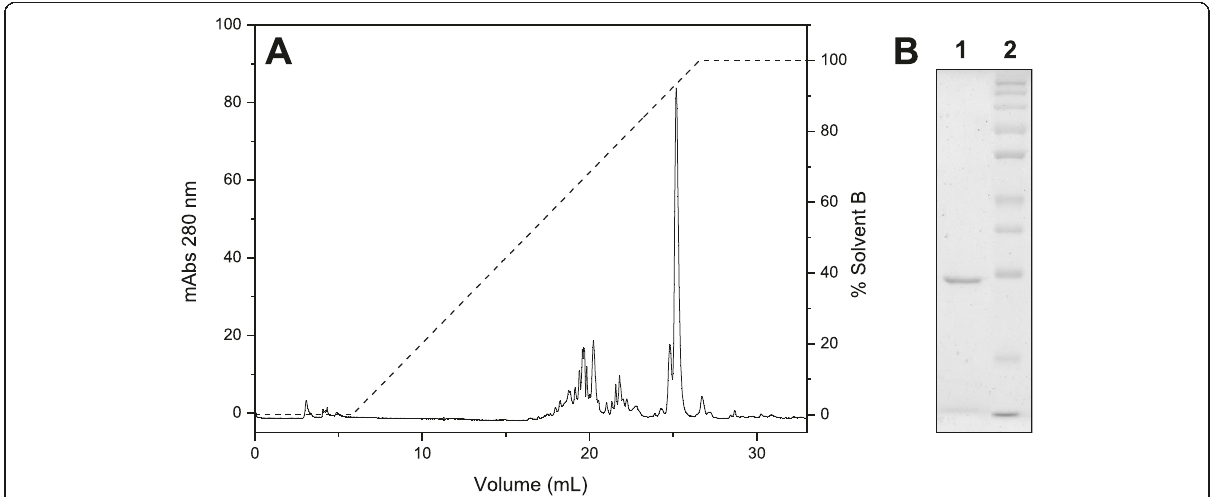
Fig. 5 a Evaluation of the purity level of fraction D4 after Vivaspin® 20 on a C18 reverse phase column. After having been subjected to ultrafiltration on a Vivaspin® 20 system, fraction D4 was evaluated by RP-HPLC using a C18 column with a linear concentration gradient of 0-100 % solvent B in five column volumes. b 12 % SDS-PAGE. Lanes: 1 – MP, 2 – molecular mass standard (260, 140, 100, 70, 50, 40, 35, 25, 15, 10